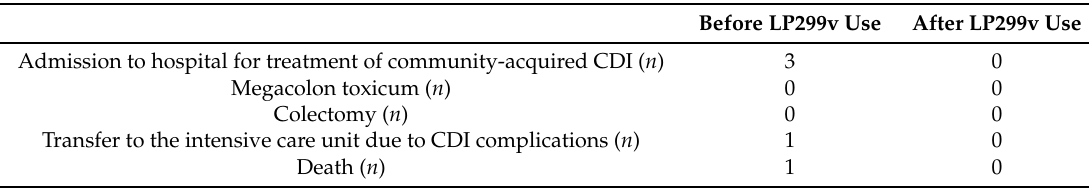
Table 2. Severe diseases associated with Clostridium difficile ( n = 5).